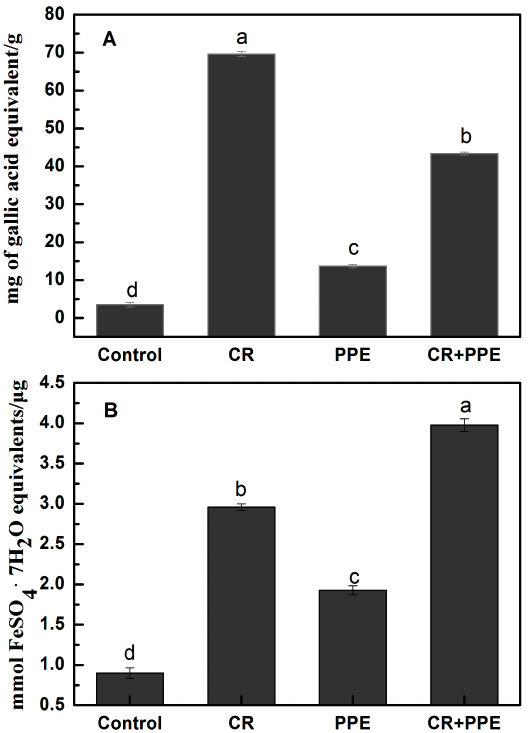
Figure 2. Total phenol contents ( A ) and antioxidant activity ( B ) for chitosan films incorporated with pomegranate peel extract and carvacrol. Each data is the mean values per treatment and time point (mean ± standard error). Values not sharing a lower case letter are significantly different at p < 0.05. PPE, pomegranate peel extract; CR,